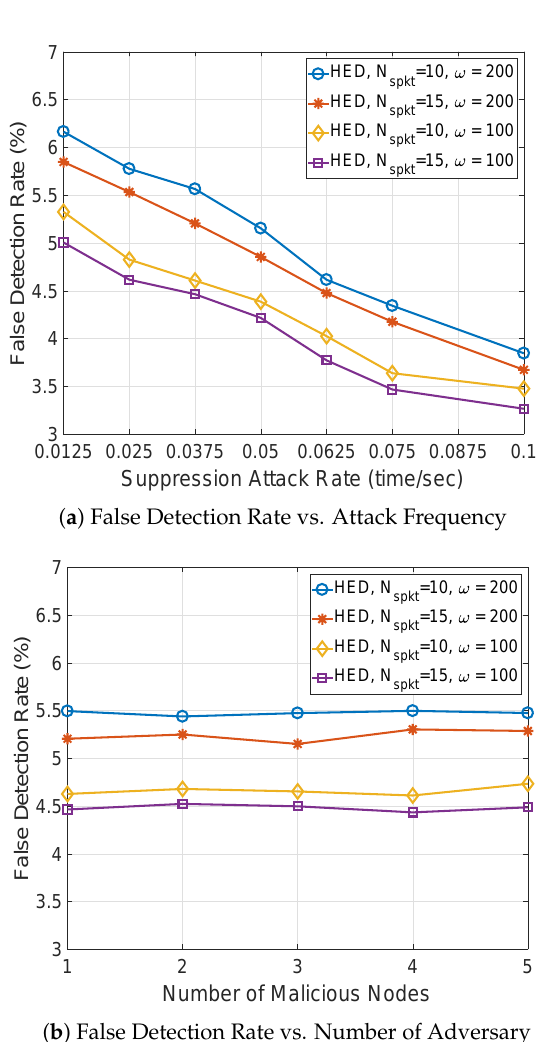
( b ) False Detection Rate vs. Number of Adversary Figure 9. The false detection rate against suppression attack rate and number of malicious